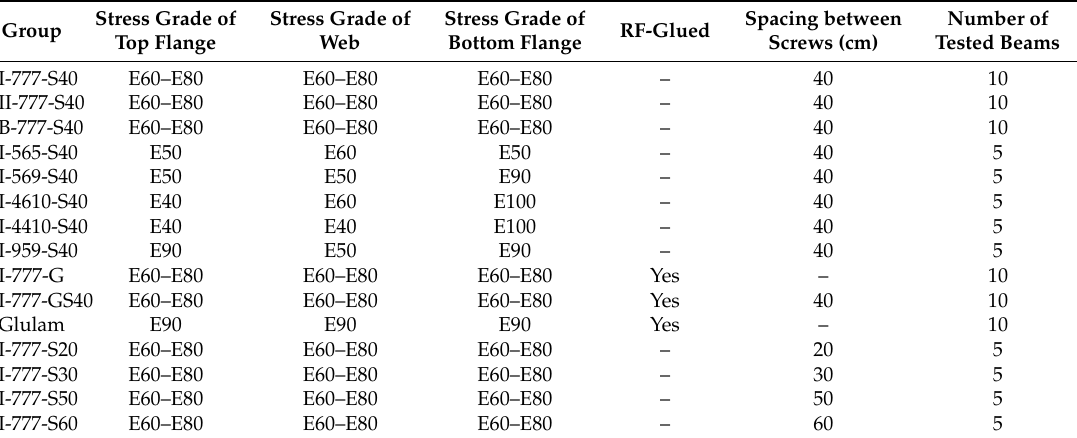
Table 1. Flange and web level of the built-up